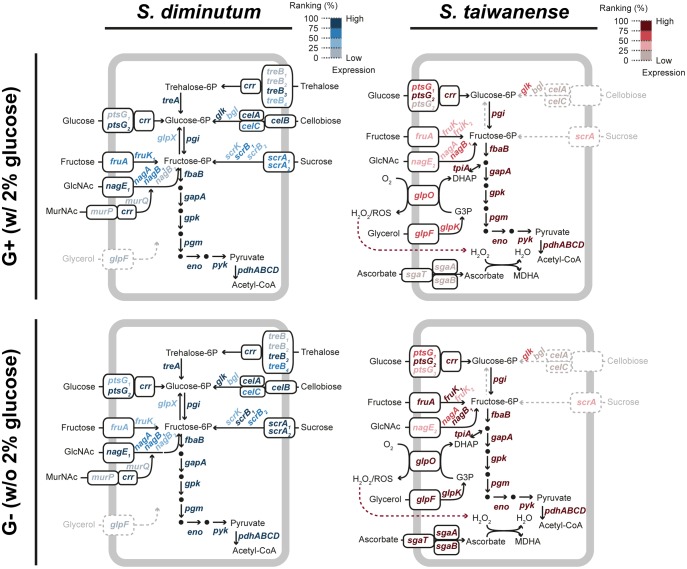
—Expression profiles of carbohydrate metabolism genes. The genes are color-coded based on the ranking of expression levels. Substrates and pathways that lack the complete sets of required genes are presented in gray.